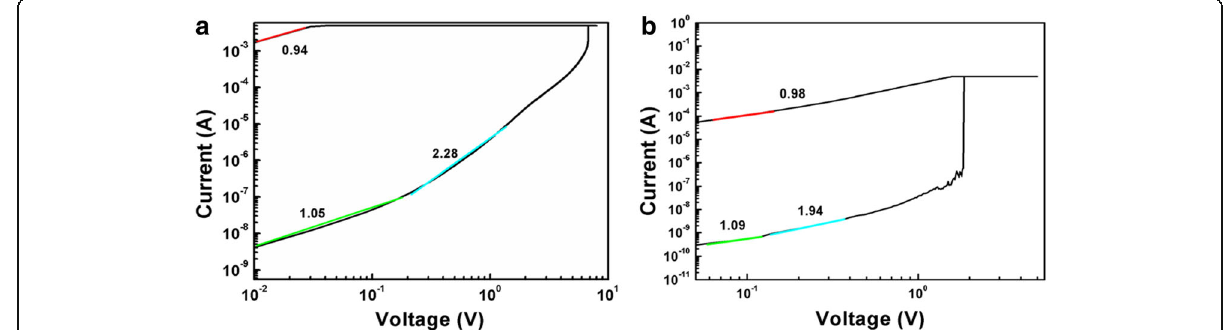
Fig. 5 The typical I – V curves plotted in double-logarithmic scale of a Pt/HfO 2 /TiO 2 /HfO 2 /Pt and b Pt/HfO 2 /TiO 2 /HfO 2 /TiN